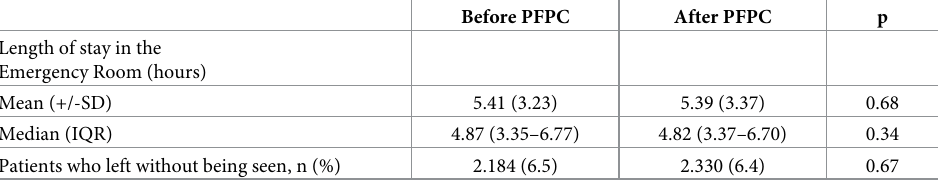
Table 4. Secondary objectives: Length of stay in the emergency room and proportion of patients who left without being seen, before and after introducing a patient-flow physician coordinator. Before PFPC After PFPC p Length of stay in the Emergency Room (hours) Mean (+/-SD) Median (IQR) 0.34 Patients who left without being seen, n (%) 2.184 (6.5) 2.330 (6.4) 0.67 SETS, Swiss Emergency Triage Scale; PFPC, patient-flow physician coordinator; SD, standard deviation; IQR, interquartile